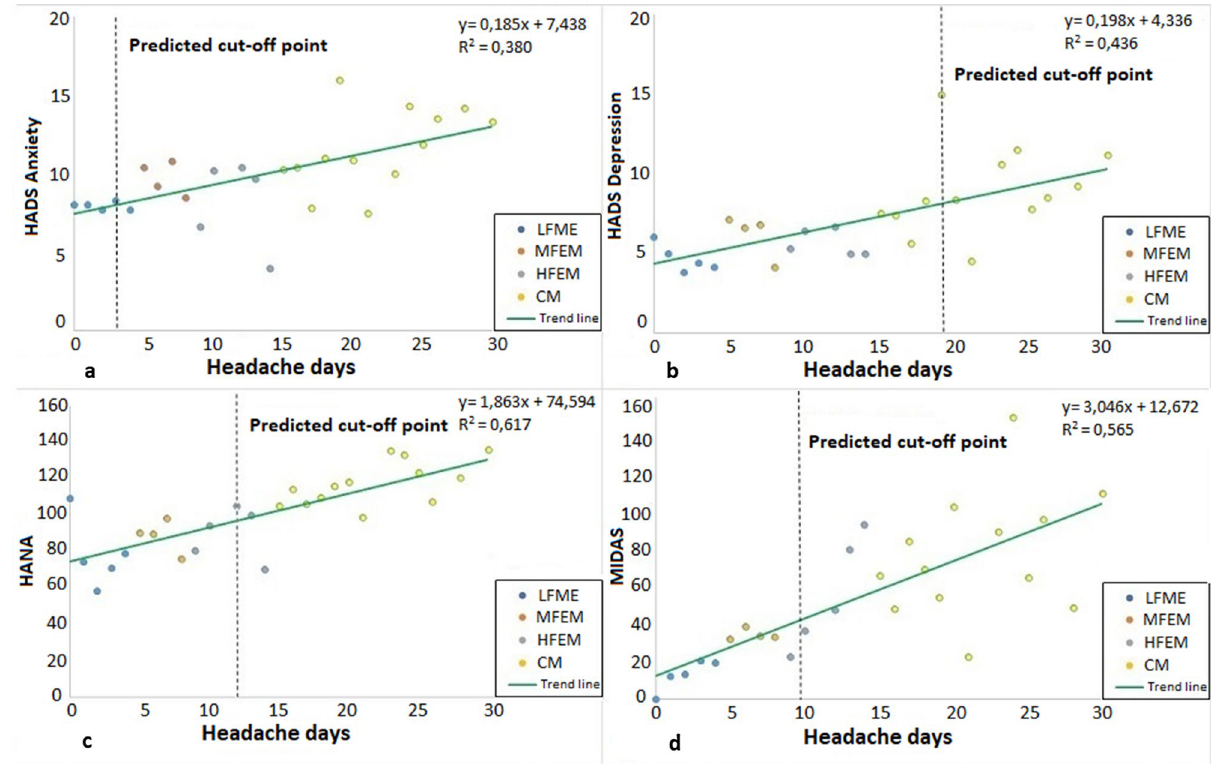
Figure 1. Scatter plot between anxiety, depression, quality of life, disability and number of days with headache. HADS: Hospital Anxiety and Depression Scale; HANA: Headache Needs Assessment; MIDAS: Migraine Disability Assessment Scale; LFEM (Low-frequency episodic migraine); MFEM (Medium-frequency episodic migraine); HFEM (High-frequency episodic migraine); CM (Chronic